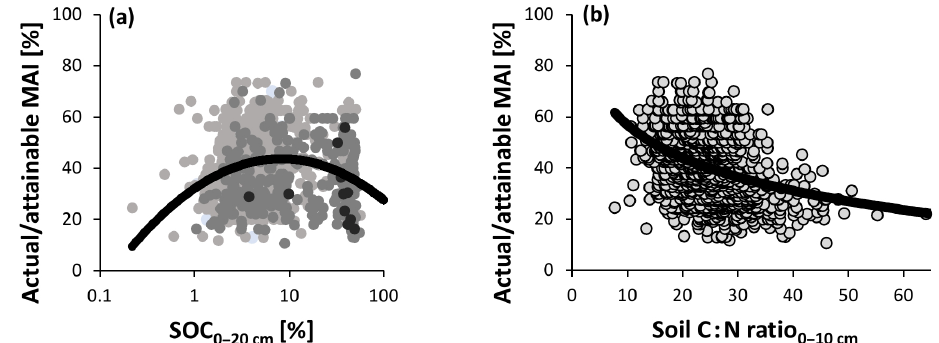
Figure 8. Relationship between normalized productivity following method 2 (actual / attainable mean annual increment – MAI for spruce); (a) log-transformed soil organic carbon concentration (SOC); (b) soil carbon-to-nitrogen ratio (C:N). Point darkness in (a) represents soil moisture (darker: moister). Statistics corresponding to the panels are presented in Table 2. Note that the horizontal axis for SOC covers a broader range here than in Fig. 1, as SOC varied widely in the Swedish database. Also note that the C:N ratio of the upper 10cm was used instead of the upper 20cm here, owing to a better description of variation in the response variable. Even though the C:N ratio roughly decreased southwards (Fig. S1d), it was only weakly correlated with the growing season temperature sum ( r =− 0.13 for C:N 0 − 20cm and r =− 0.28 for C:N 0 − 10cm